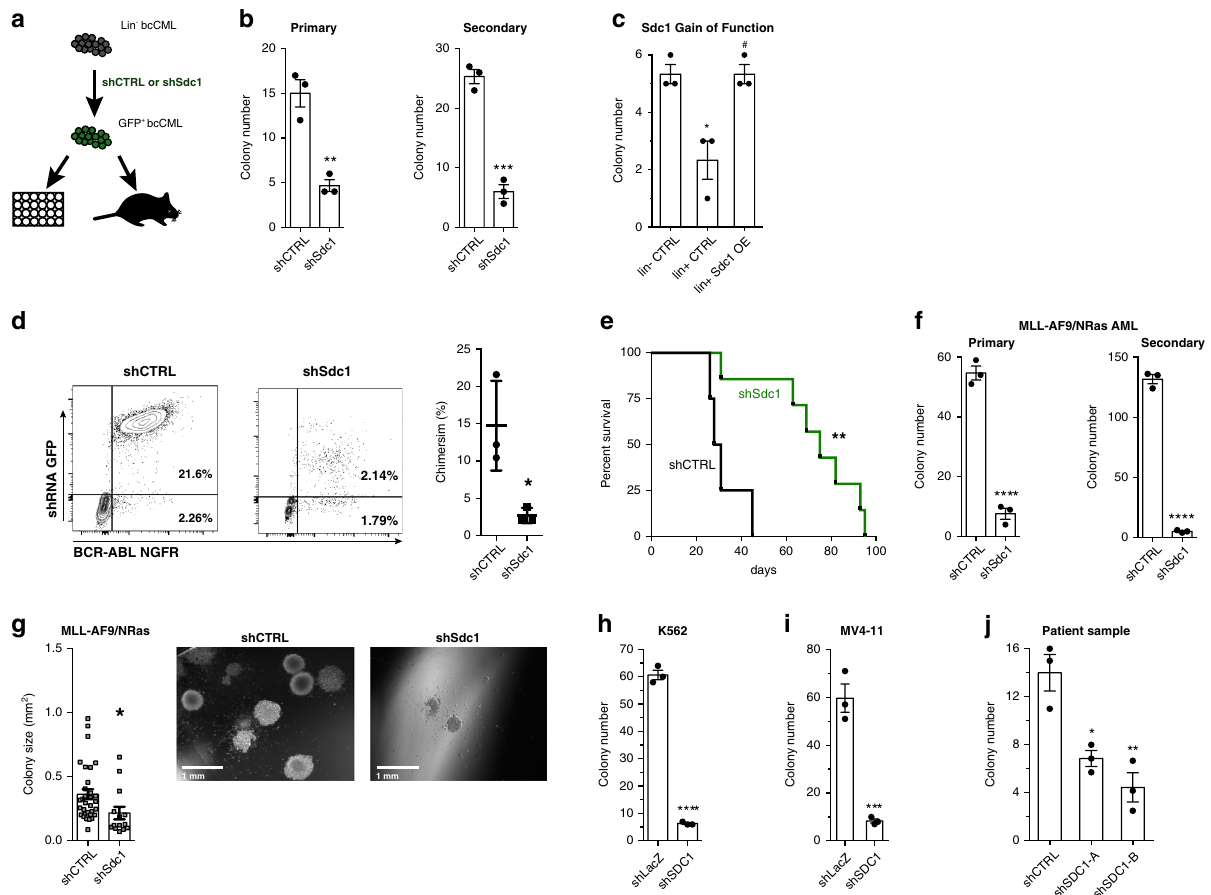
Fig. 5 Syndecan-1 loss impairs established bcCML growth in human and mouse models. a Approach to assess the impact of Sdc1 loss on established bcCML. b Colony formation of shCTRL or shSdc1 bcCML ** P = 0.003, *** P = 0.0003 ( n = 3 technical replicates, representative of three biological replicates). c Impact of ectopic Sdc1 expression in Lin + bcCML. * P = 0.02 from Lin − CTRL, # P = 0.01 from Lin + CTRL ( n = 3 technical